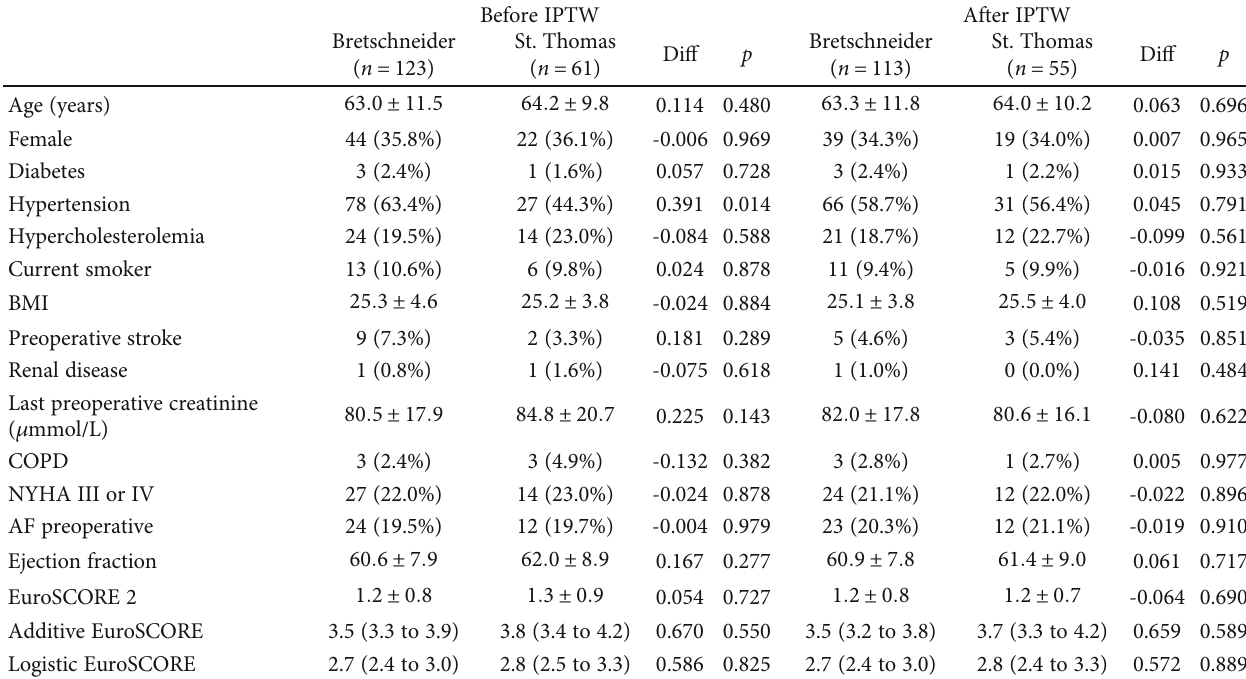
Table 1: Patient